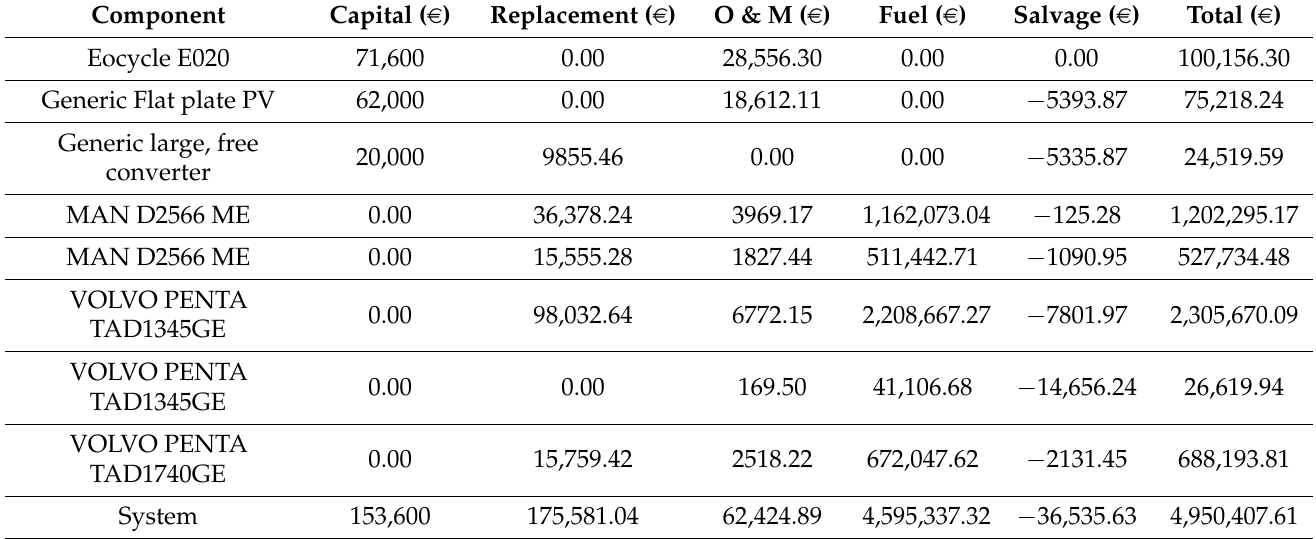
Table 13. Analytical costs of each component Scenario